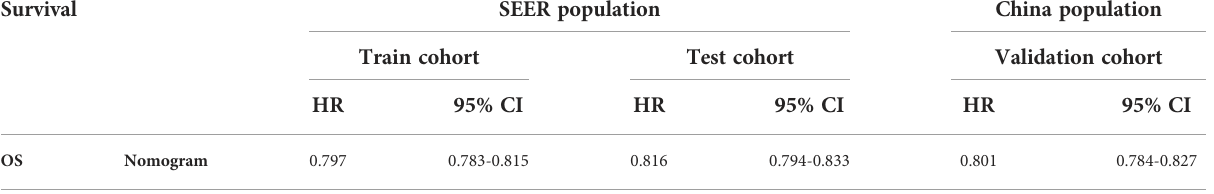
TABLE 3 C-indexes for the nomogram in patients with GEP-NECs. Survival